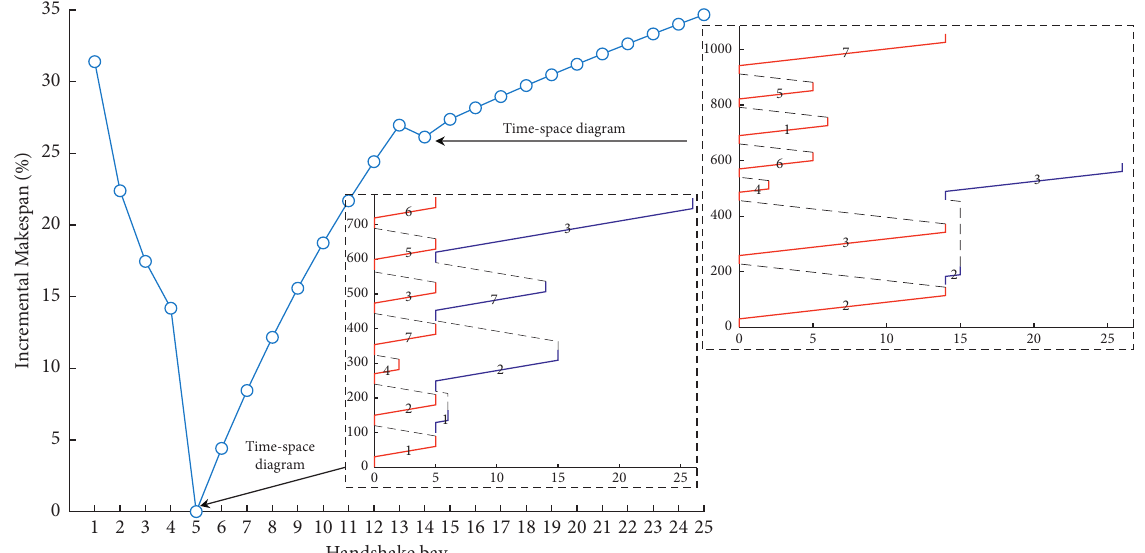
Figure 8: Impact of handshake bay on the